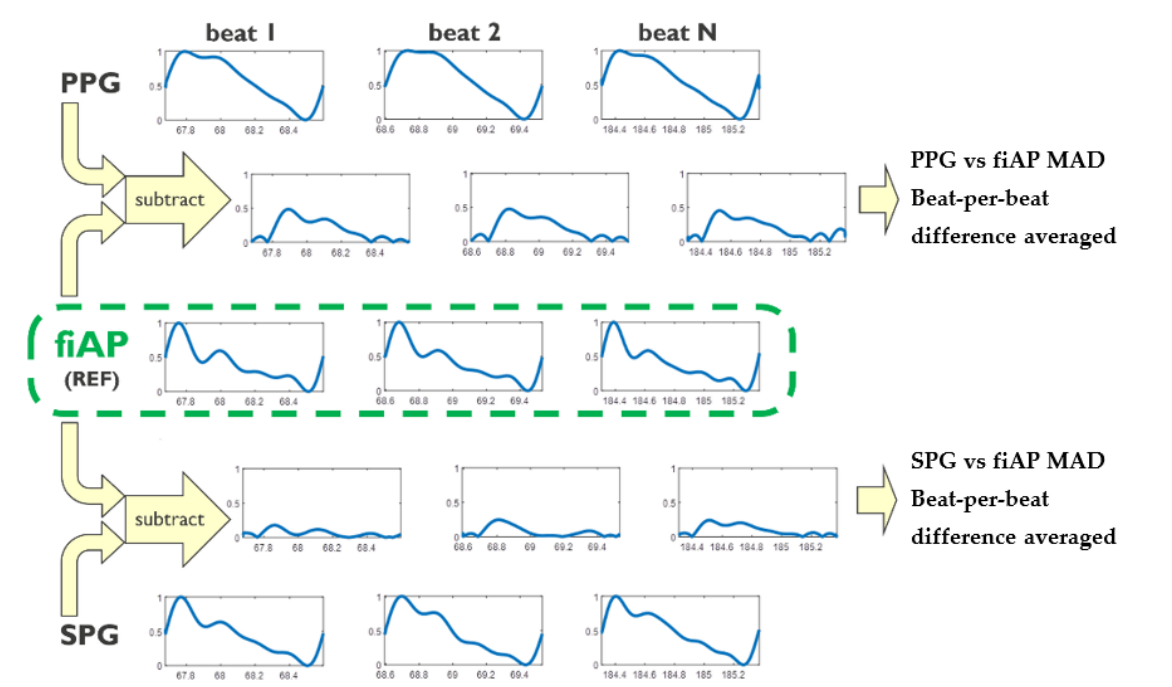
Figure 2. Comparison of PPG ( top ) and SPG ( bottom ) waveform morphologies with non-invasive Finger Arterial Pressure (fiAP) reference. For boxplots of the resulting PPG vs. fiAP and SPG vs. fiAP see Section 4.